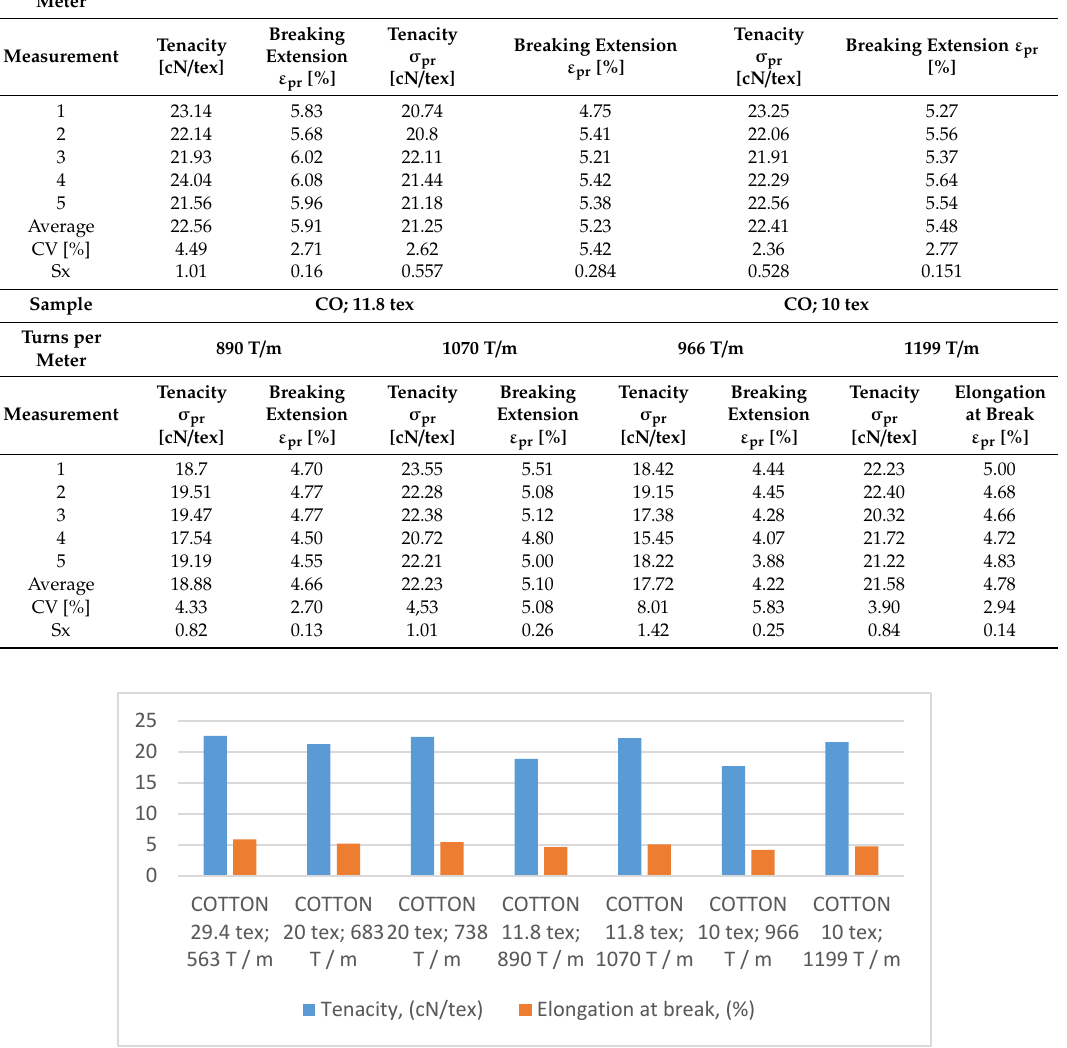
Figure 5. Average tenacity and elongation at break of the samples analyzed.